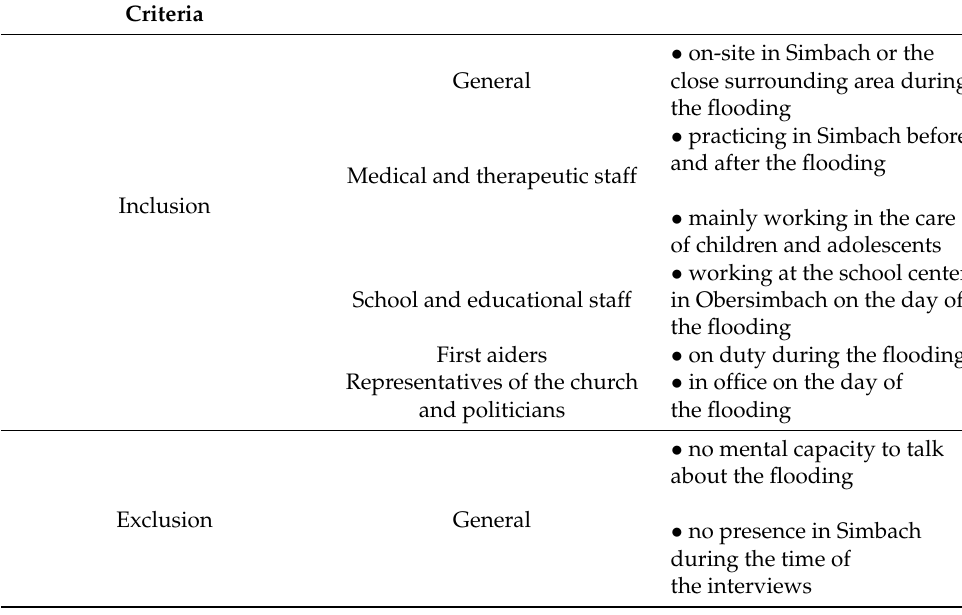
Table 2. Inclusion and exclusion